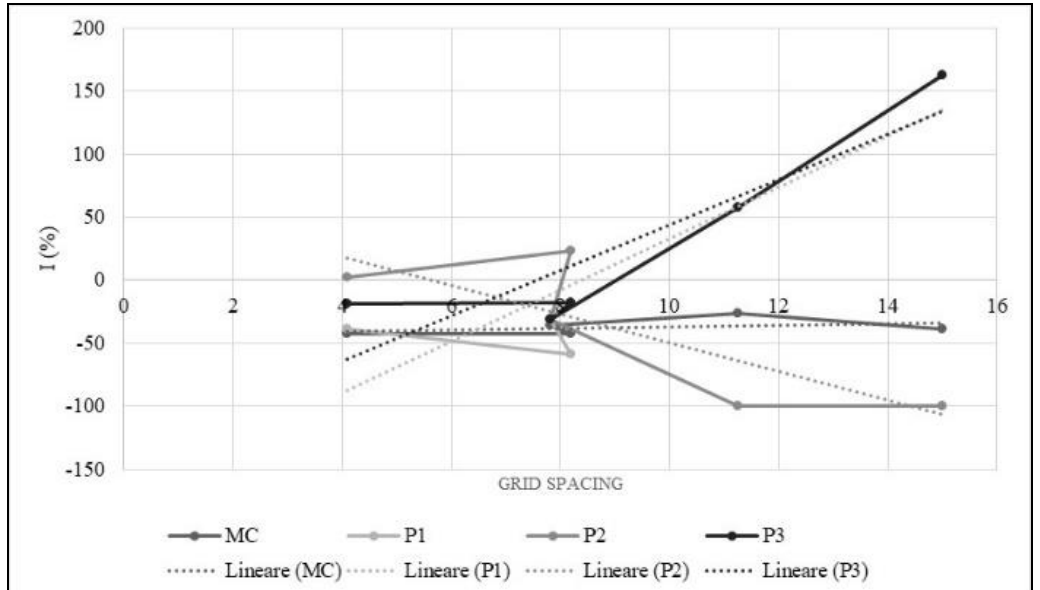
Figure 14. Variability of the I index within the type of defect. Buildings 2018 , 8 , x FOR PEER REVIEW